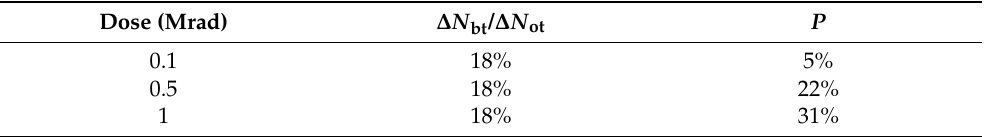
Table 3. ∆ N bt / ∆ N ot of the 5 V NMOSFETs under test and proportion of interface traps that exchange carriers with border traps to the total interface